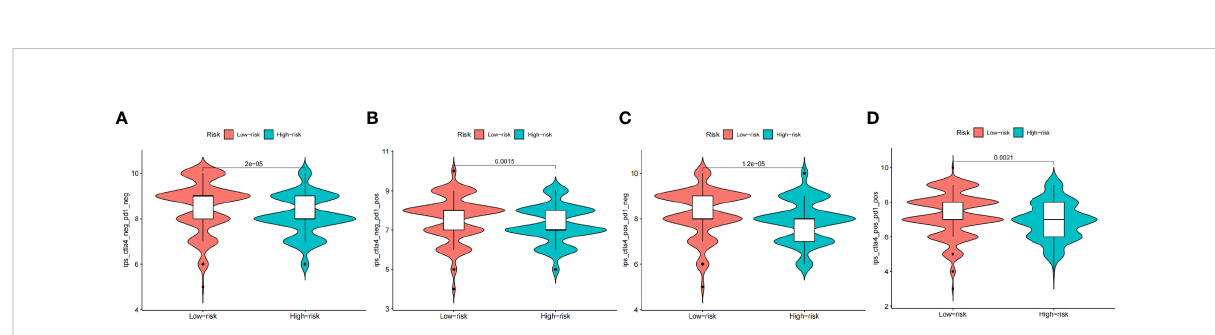
FIGURE 9 The prognostic value of CAFS-score in immunotherapy from TCGA cohort. (A – D) The vioplot of the difference expression of CTLA4 and PD-1 between high- and low-risk groups.